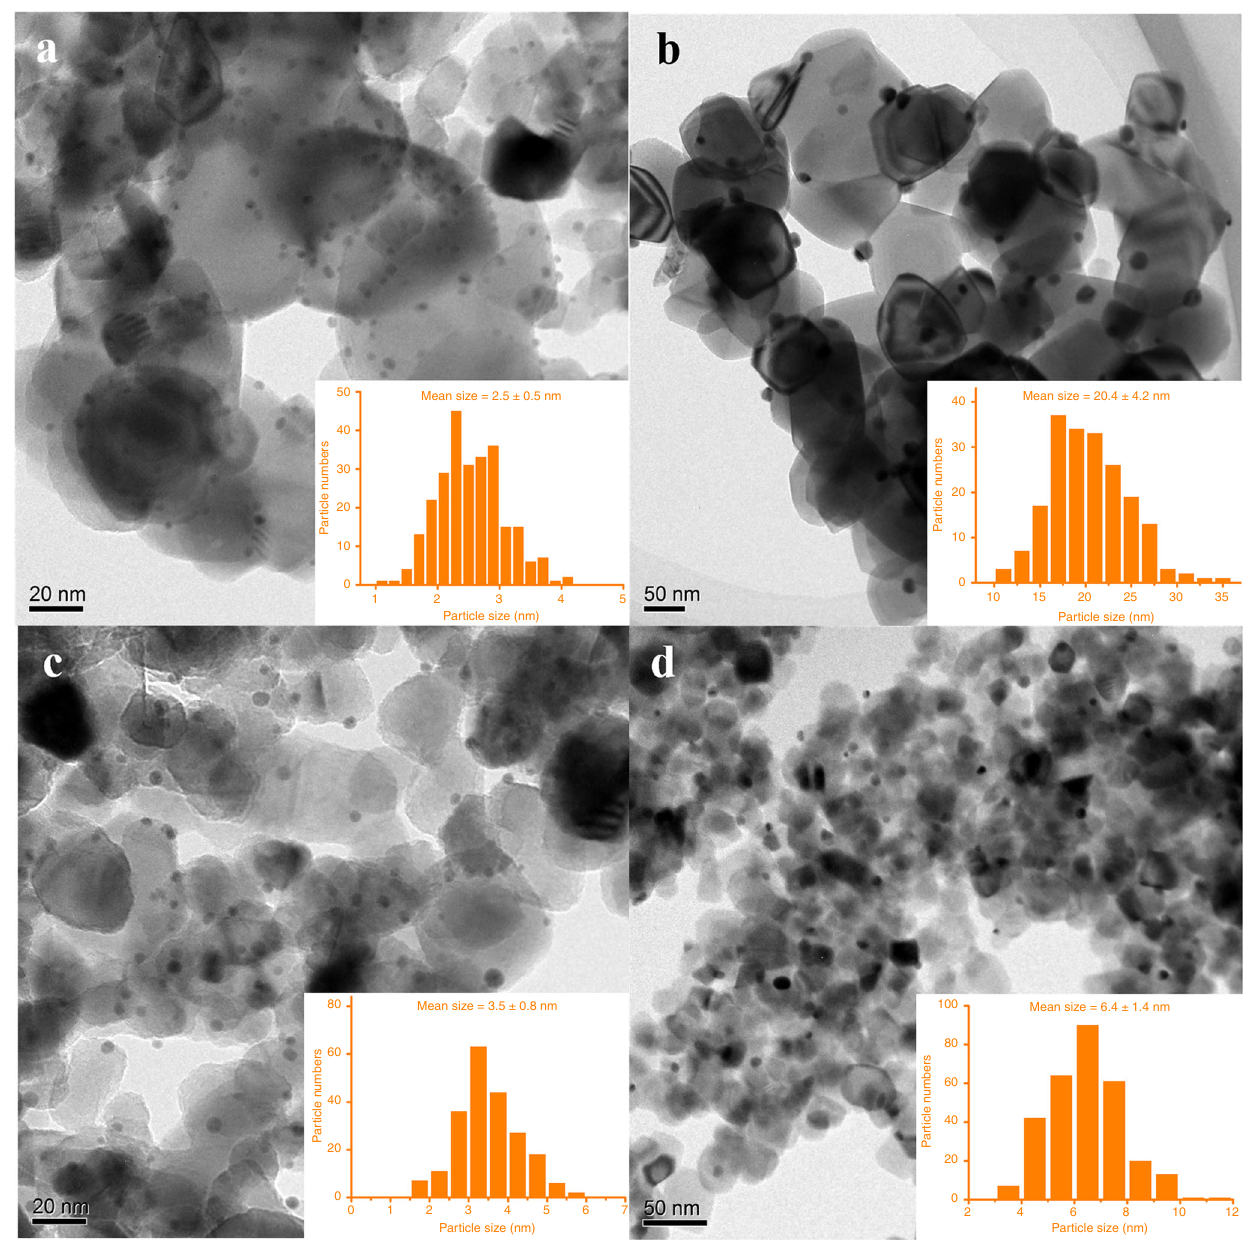
Fig. 1 HRTEM images and corresponding size distributions of gold NPs for different gold catalysts. a Au/Ti-300; b Au/Ti-800; c Au@SiO 2 /Ti-300; d Au@SiO 2